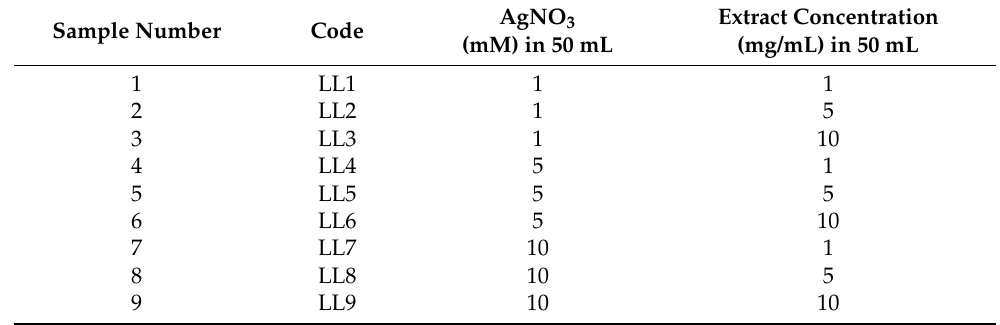
Table 1. Code assigned to different concentrations of silver nitrate and Ligustrum lucidum leaf